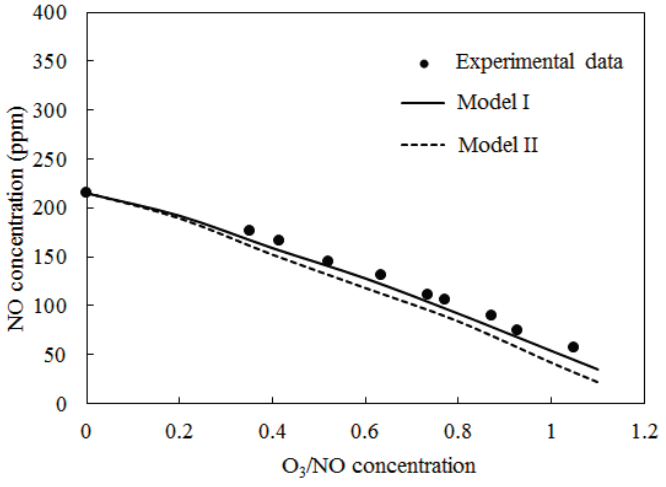
Figure 4. Variations of NO concentration with O 3 /NO concentrations at T = 100 °C.